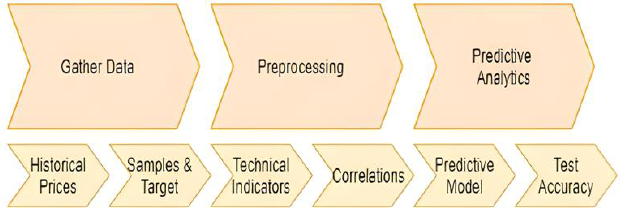
Figure 5. Overview of methodology for foreign exchange prediction based on technical indicators.